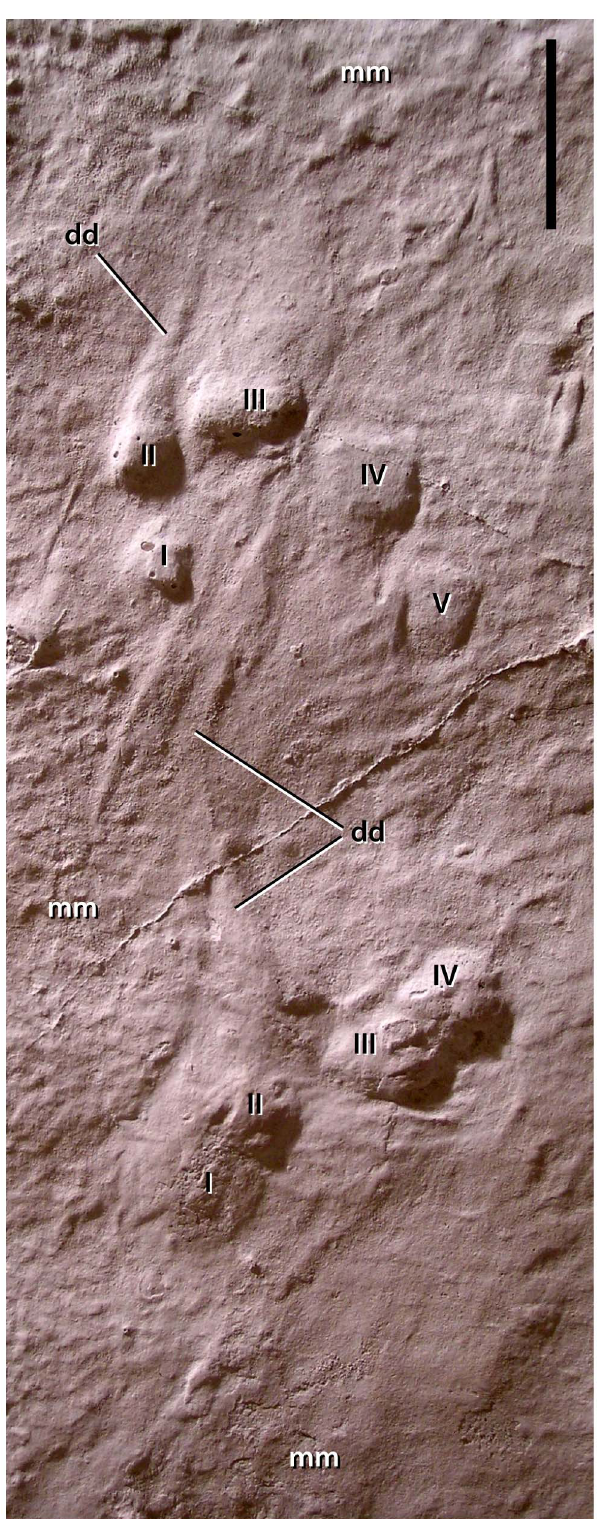
Figure 5. Episcopopusventrosus. Right manus-pes pair 56 demon- strating the superposition of the pes print over the manus drag. Note that this is photograph of a cast (positive), with light directed from the upper left. The pentadactly pes ( I – V ) is positioned forward of